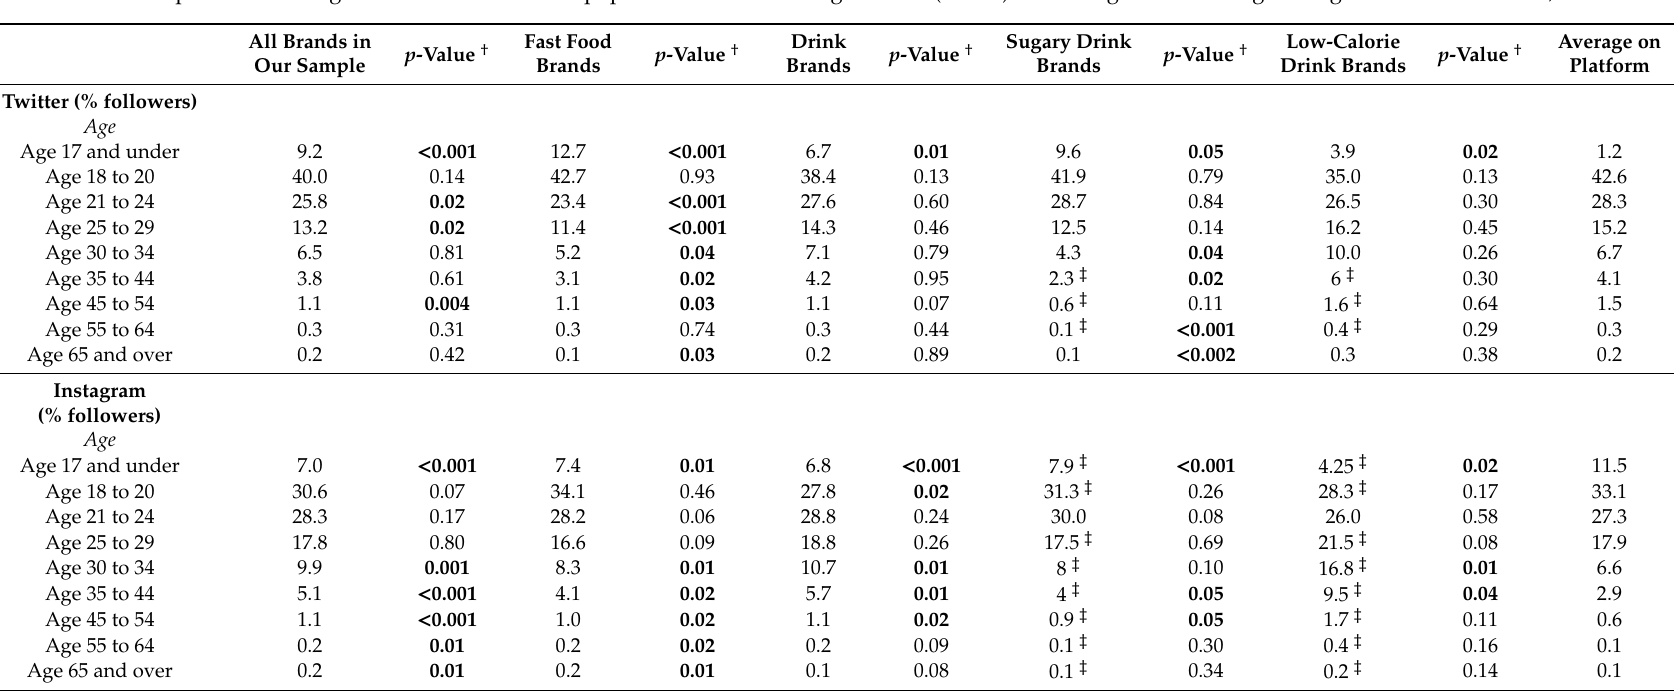
Table 3. Comparison of the age of users who followed popular food and beverage brands ( n = 27) and the age of the average Instagram and Twitter user, 2019. All Brands in Our